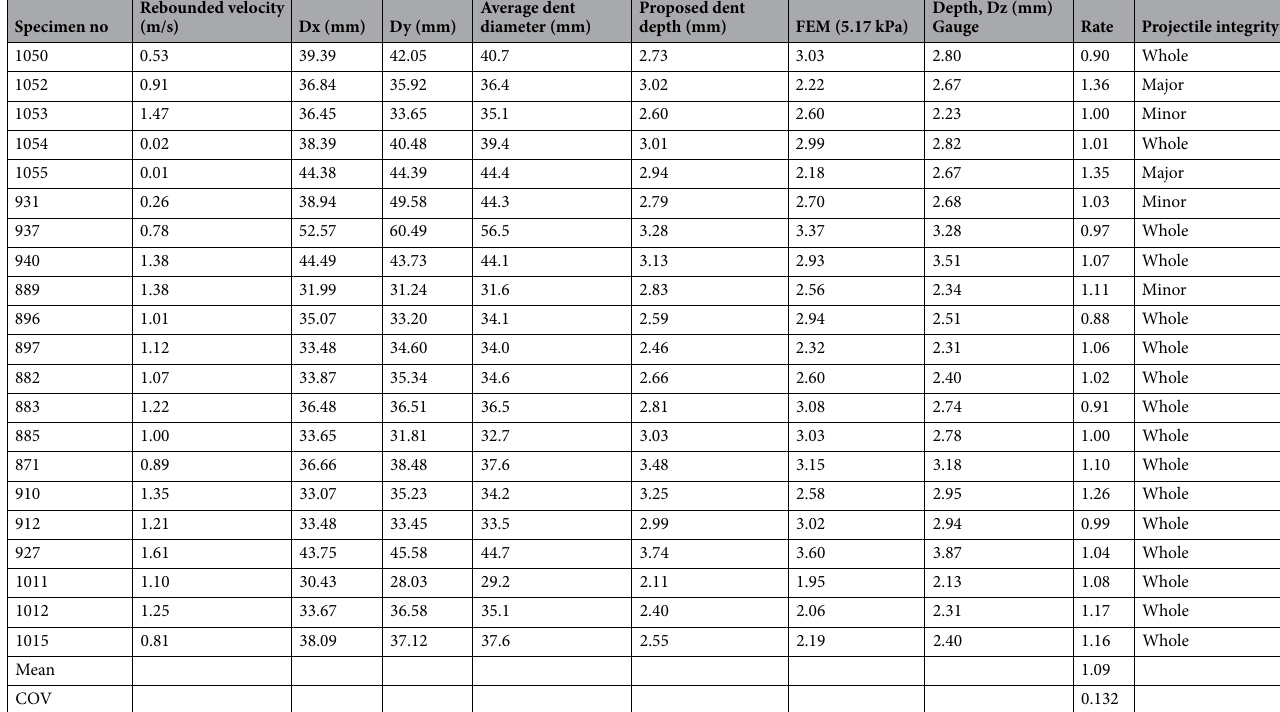
Table 3. Measured dent depths and diameters on the steel sheets after impact.